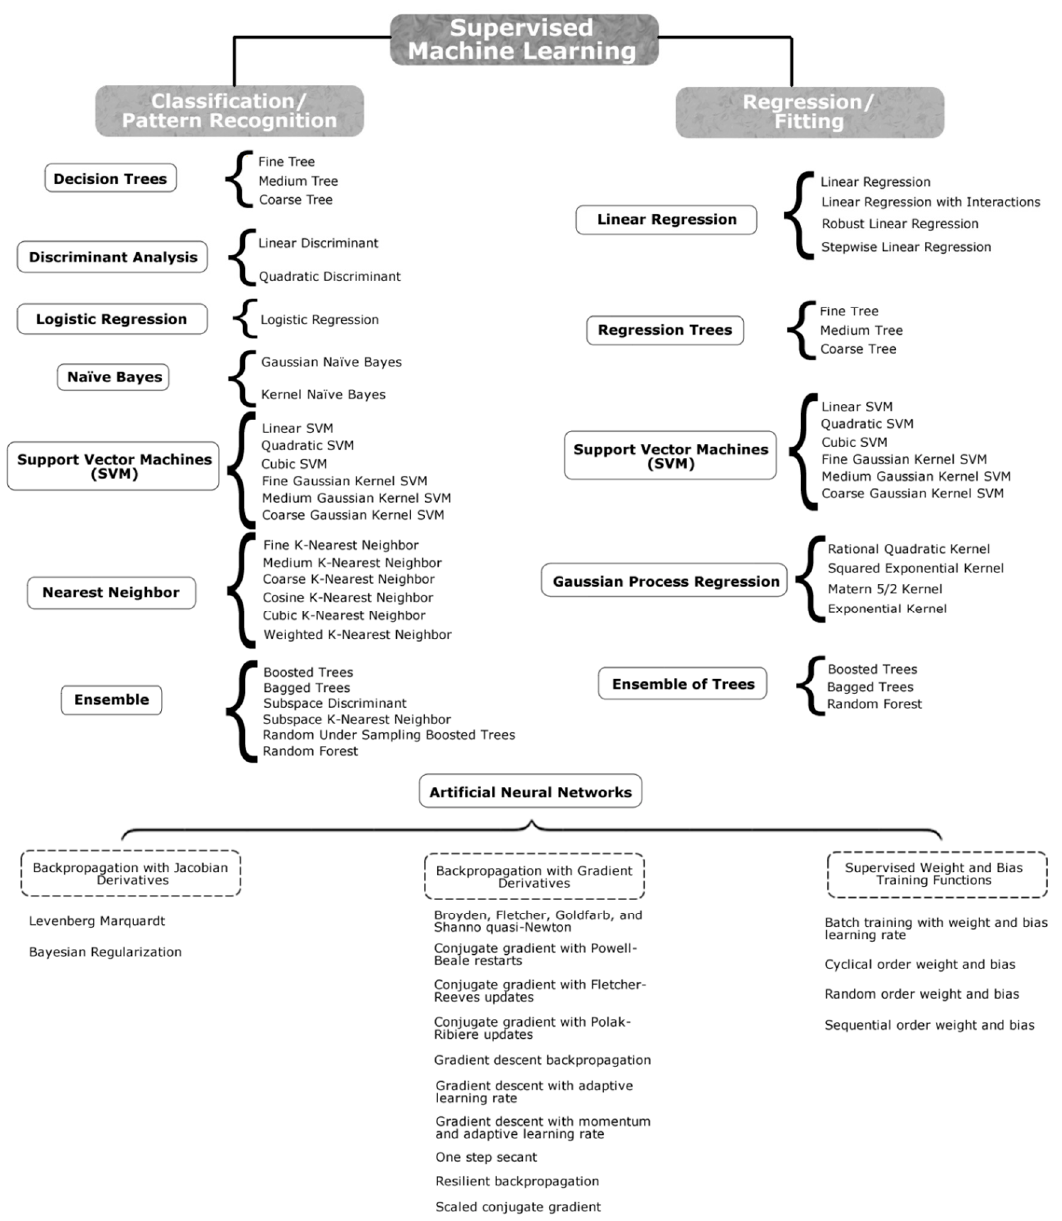
Figure 2. Types and algorithms for machine learning modeling. Information obtained from Matlab Machine Learning and Deep Learning Toolboxes [89].